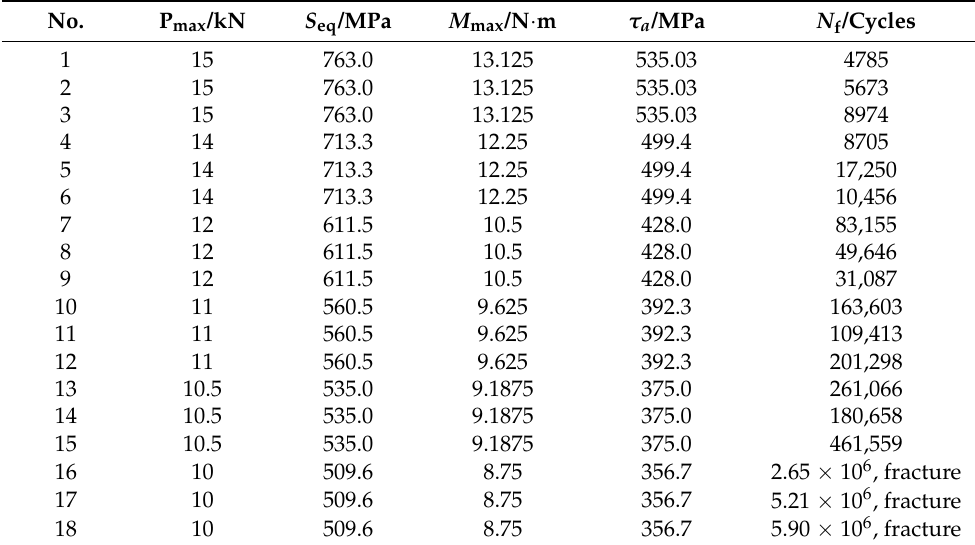
Table 1. Fatigue test results of proportional tension–torsion loading.